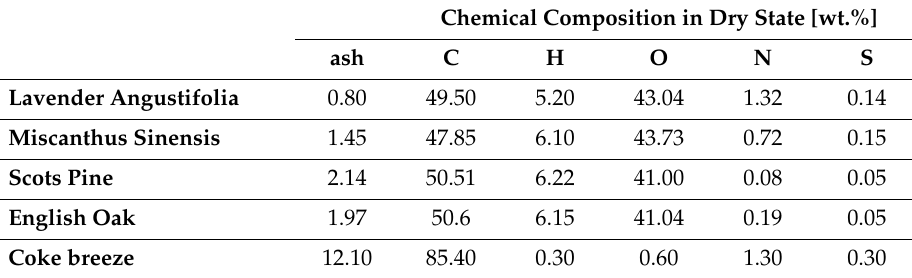
Table 2. Chemical composition of biomass (ultimate analysis).